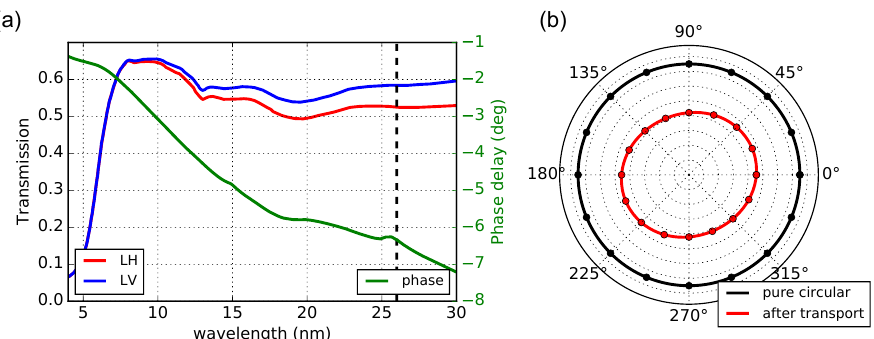
Figure 3. ( a ) calculated transmission of the LDM beamline optics for the FEL-2 line, for the horizontal linear polarization ( red ) and the vertical linear polarization ( blue ) [36] and simulated phase delay between vertical and horizontal polarization ( green ); ( b ) predicted photoelectron angular distribution in the case of a perfect circular polarization ( black ) and including the effect of the optical transport system ( red ) at 26 nm (dashed line in a